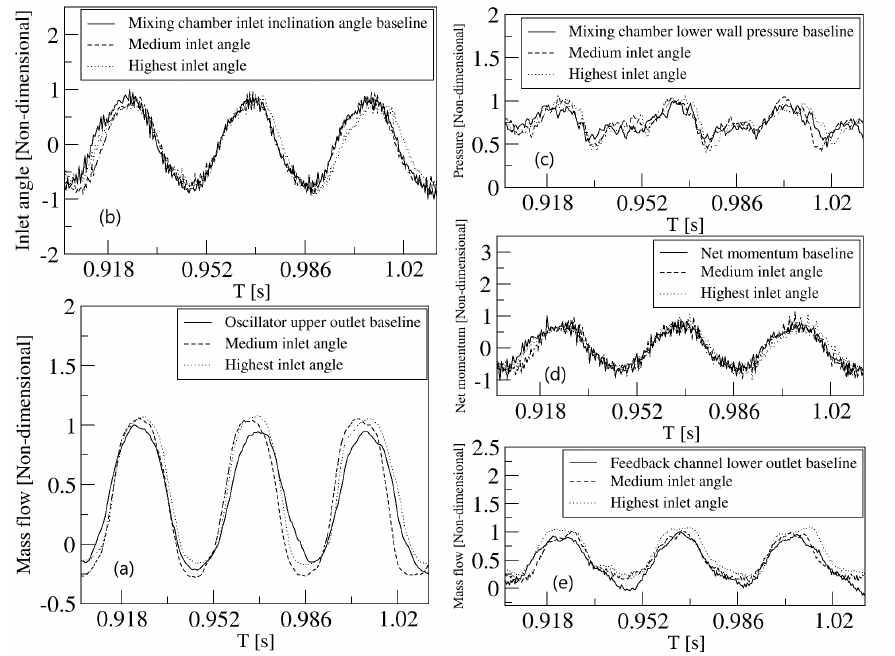
Figure 15. Dynamic effects of the (MC) inlet angle modification on the main flow parameters, Reynolds number 16034. Each graph presents three non-dimensional curves characterizing results from the baseline, the medium and highest inlet angle cases, and as a function of the dimensional time. In figure ( a ) the mass flow across the upper oscillator outlet is presented. Figure ( b ) introduces the temporal variation of the (MC) inlet inclination angle. Figures ( c ) presents the pressure at the (MC) lower inclined wall. The net momentum acting on the lateral sides of the main jet is presented in figure ( d ). Figure ( e ) characterizes the mass flow at the lower feedback channel